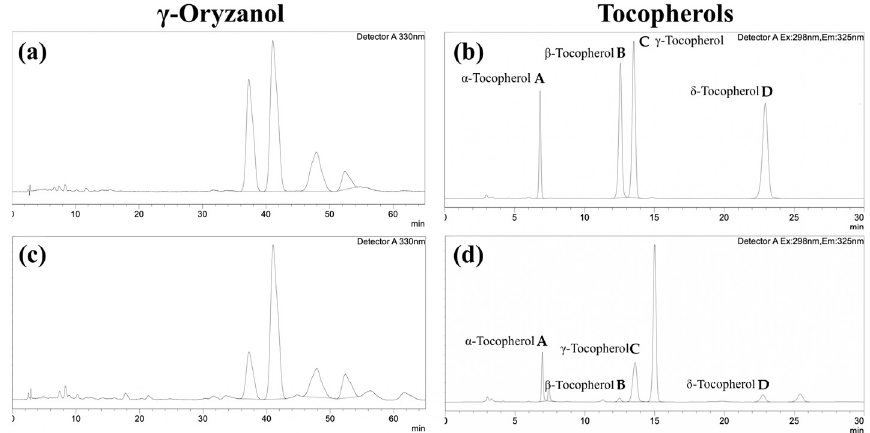
Figure 1. High performance liquid chromatography (HPLC) chromatograms of ( a ) standard γ -oryzanol, ( b ) standard tocopherols, ( c ) γ -oryzanol in Oryza sativa L. cv. Khao Dawk Mali 105 (KDML105) bran extract, and ( d ) tocopherols in KDML105 bran extract.